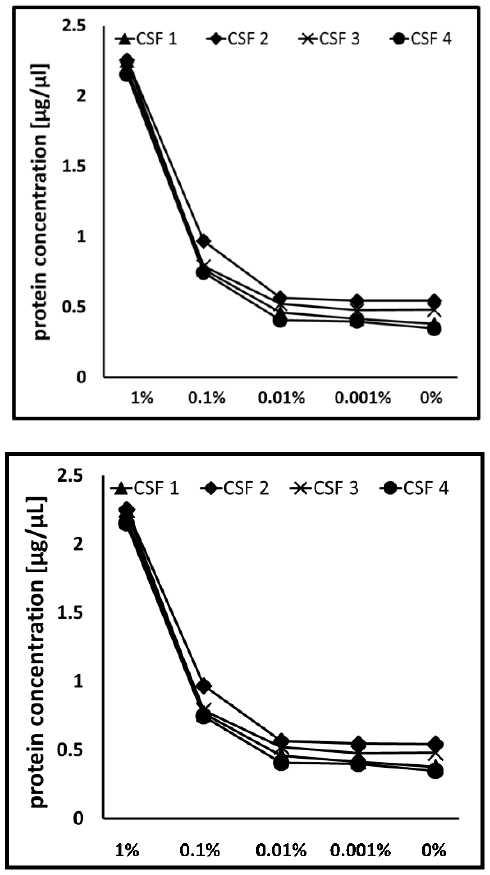
Figure 5. Comparison of the impact of different blood contamination levels on the protein concentration. Dependent on increased spike-in blood concentrations, increase of protein concentration was observed starting from the spike-in concentration of 0.1%.